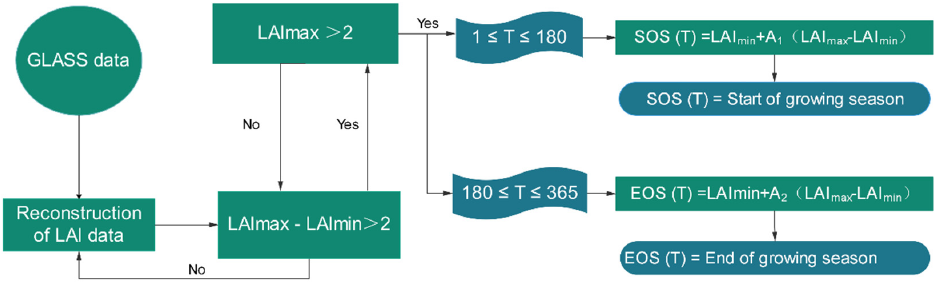
Figure 3. Flow chart of the dynamic threshold method used to extract the phenological features of P. euphratica .